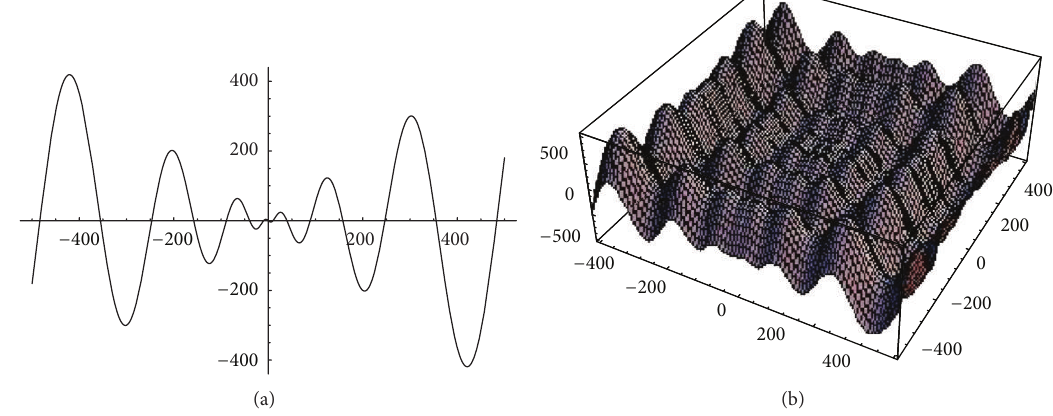
Figure 4: Surface of Schwefel’s function: (a) 1-dimension; (b)